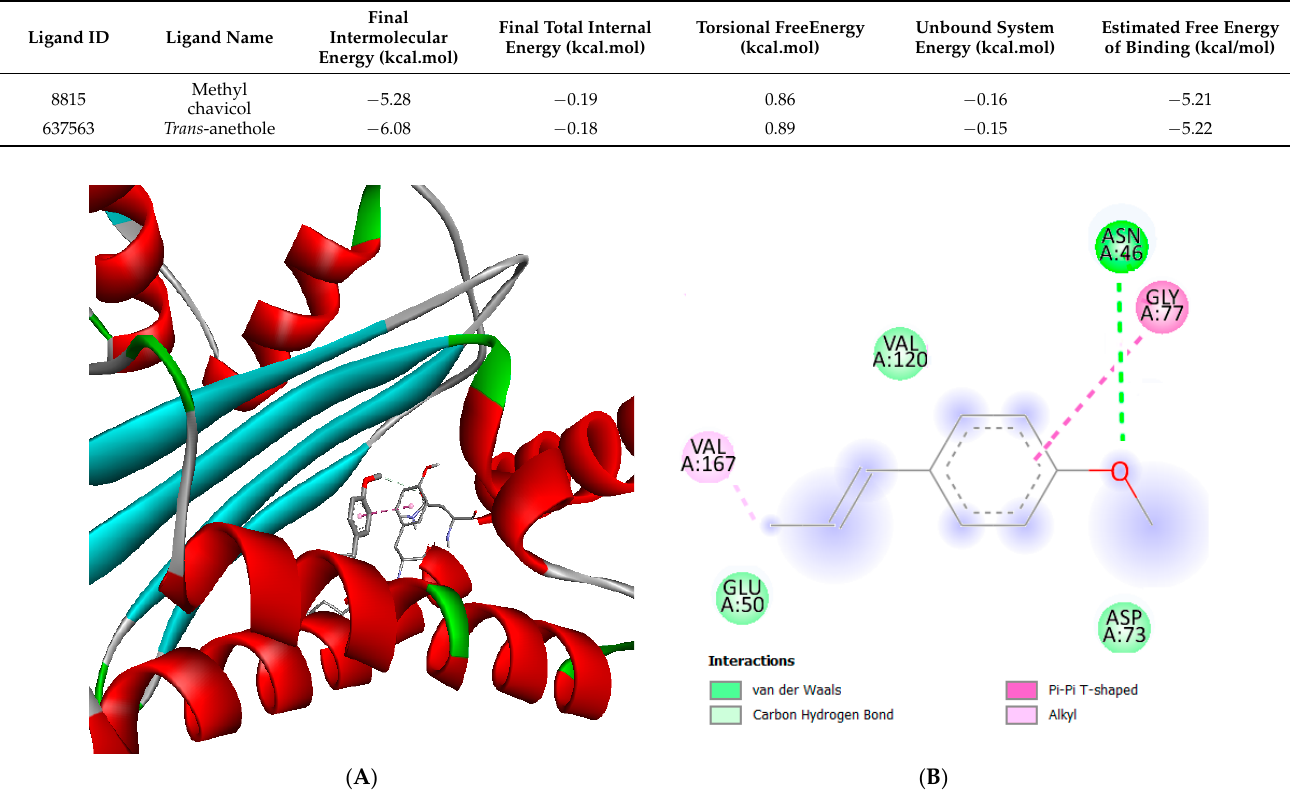
Figure 2. 2D diagram ( A ) and 3D representation ( B ) of the docking pose of the inhibitor trans -anethole in the active site of E. coli DNA gyrase B (PDB ID: 4DUH) with an RMSD of 0.575 Å.